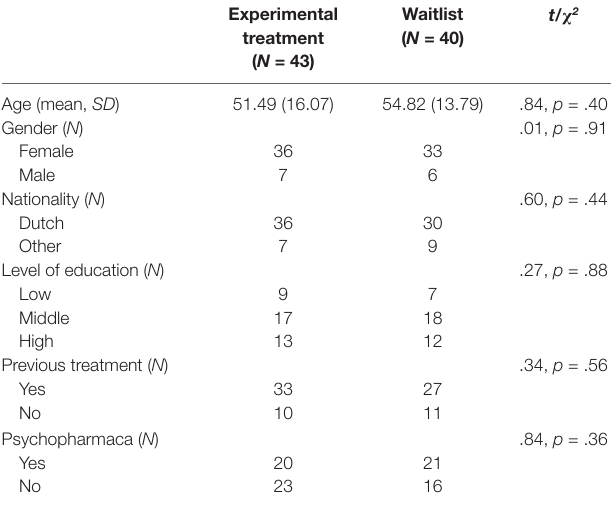
TABLE 2 | Patients’ baseline characteristics: sociodemographic and clinical variables. Experimental